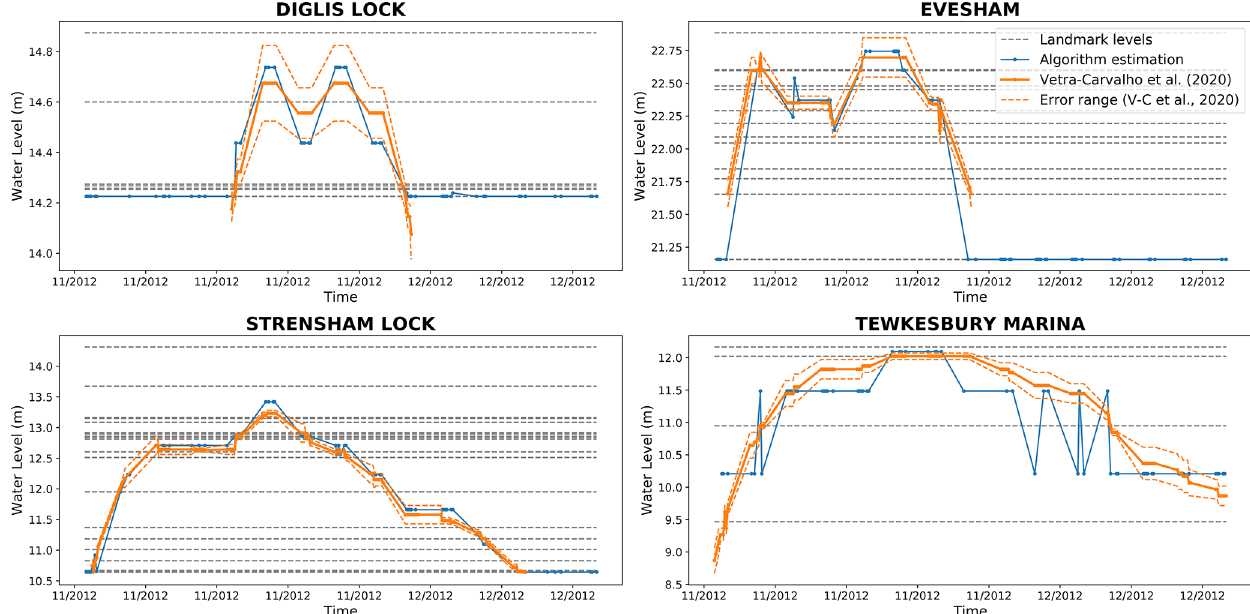
Figure 6. Comparison of the water-level estimation method using the DeepLab-LAGO-2STEPS network (in blue) and using the landmarks with the ground truth water levels directly extracted from the images (Vetra-Carvalho et al., 2020b) (in orange). The horizontal dashed lines correspond to the heights of the landmarks ground surveyed on these locations (see Sect. 3.1.1) that can be used as lower and upper bounds by the water-level estimation algorithm LBWLE (see Sect. 2.3.2). Note that the water-level estimation performed by manual examination of the images (Vetra-Carvalho et al., 2020b) was not always available outside of the flood event itself (Diglis Lock, Evesham and